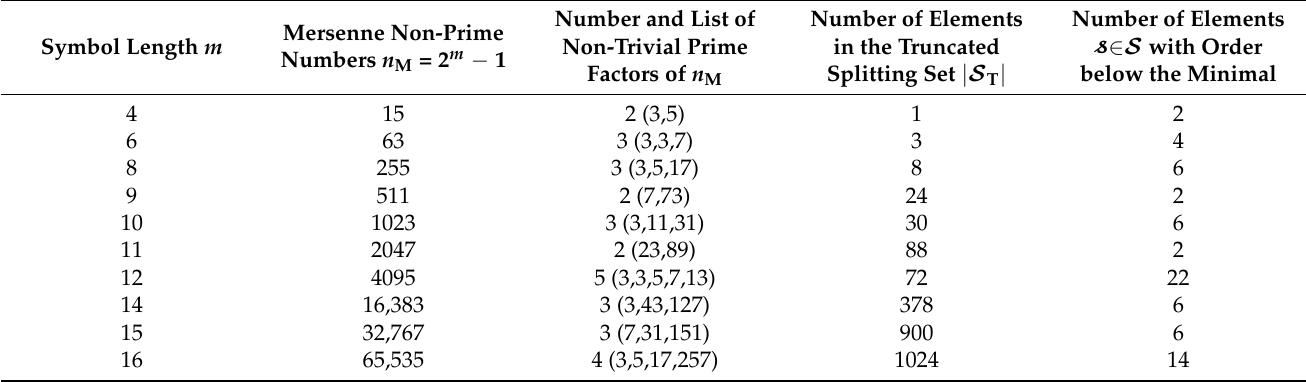
Table 2. The cardinality of the truncated splitting sets S T .